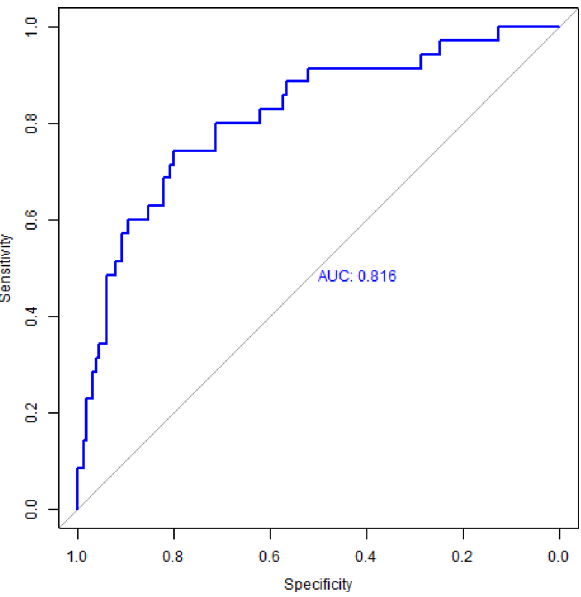
Figure 2. Model Performance ROC. Note Ensemble model performance reflects an AUC of 0.816 (accuracy = 0.806, balanced sensitivity = 0.743, balanced specificity of 0.80, Cohen’s kappa =